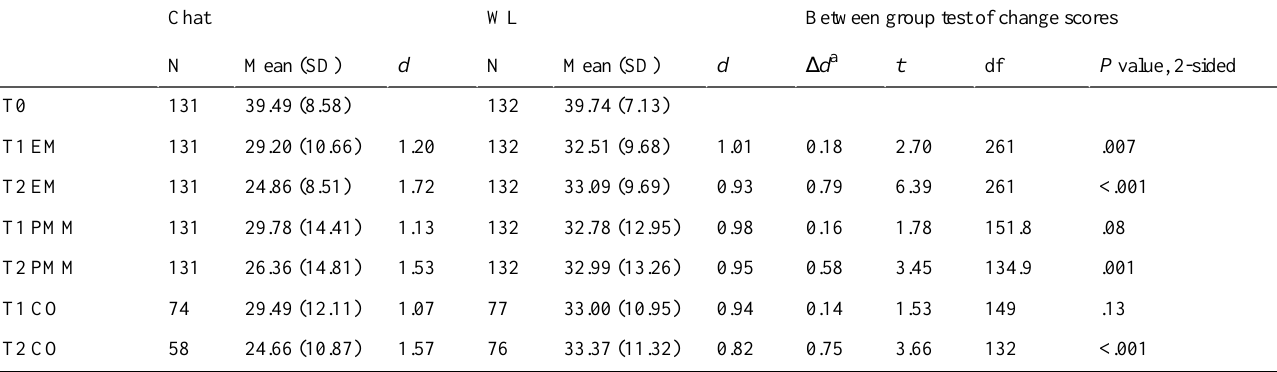
Table 2. Means and estimates for depression score (CES-D) at 9 weeks (t1) and 4.5 months (t2) follow-up: intention-to-treat (EM imputation) and completers only (CO) analysis.